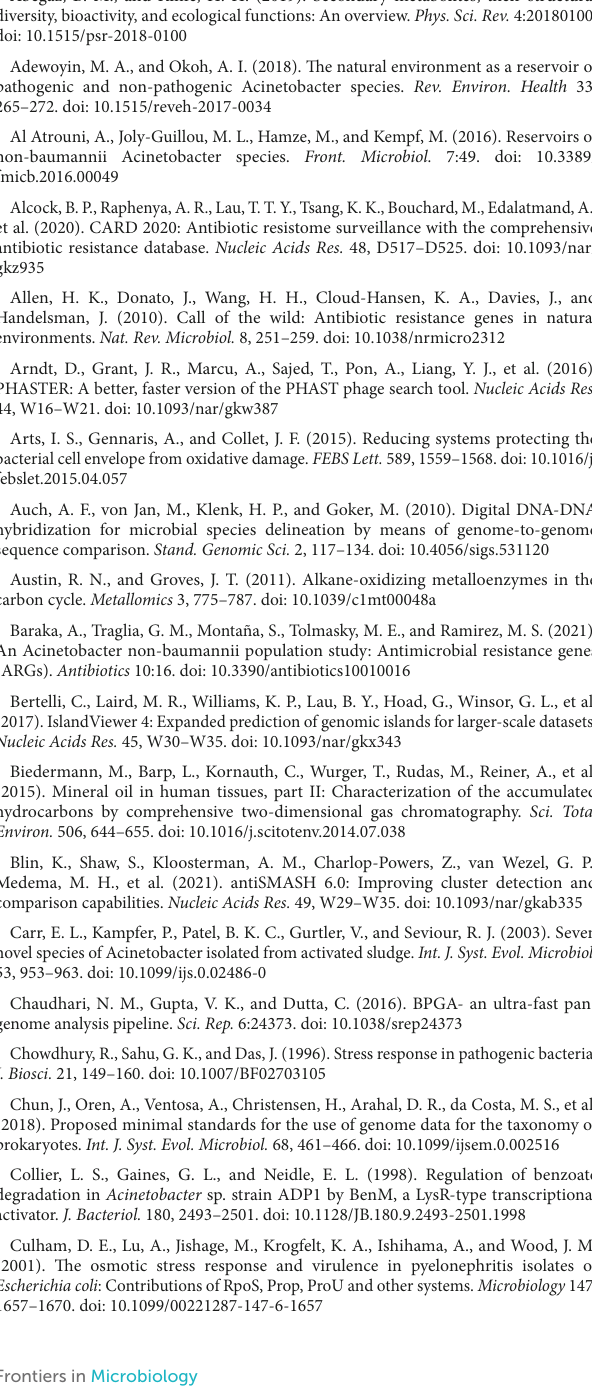
processing. Classes C, G, E, F, H, I, Q and P are involved in Metabolism. Classes R and S belong to the category of Poorly characterized. SUPPLEMENTARY FIGURE S2 COG distribution of 33 typic Acinetobacter strains. (A) COG distribution of core genes, accessory genes and unique genes in information storage and processing, cellular processes and signaling, metabolism and poorly characterized. (B) COG distribution of core, accessory and unique genes. Classes D, M, N, O, T, U and V are involved in Cellular processing and